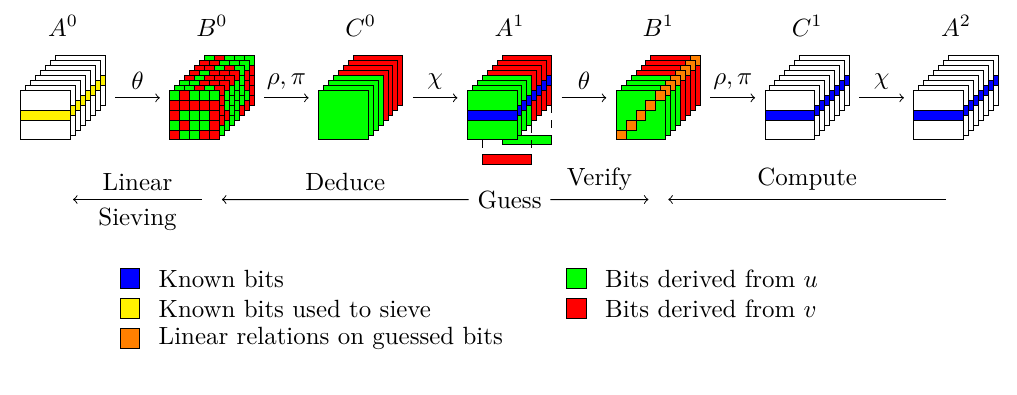
Figure 6: Divide-and-conquer attack against initial Ketje Jr with rate 40 bits with guessing of parity